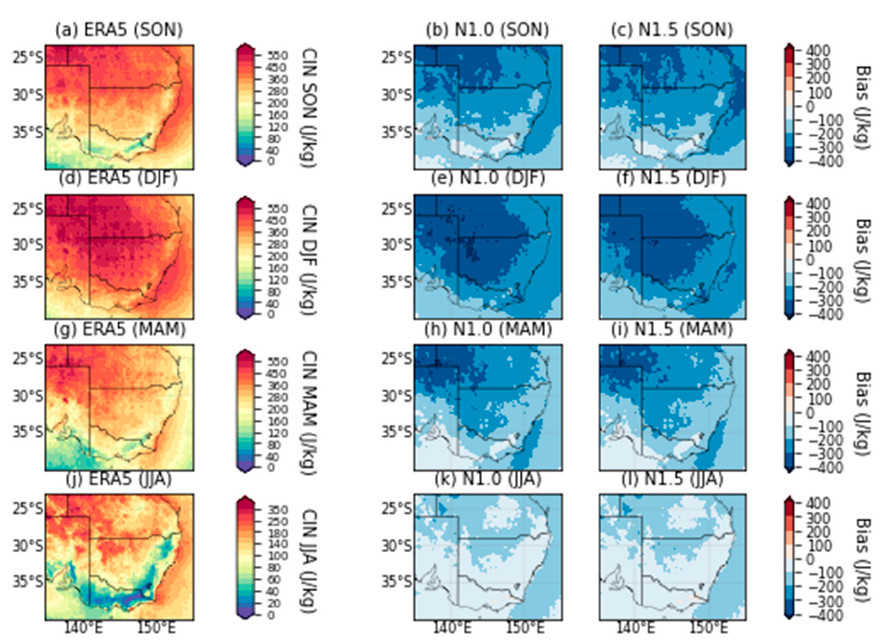
Figure A18. As in Figure A16 except for CIN.